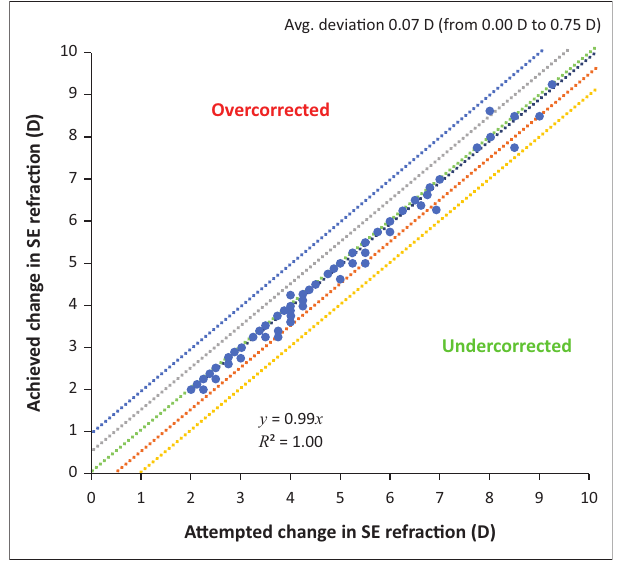
FIGURE 3: Attempted versus achieved SE at 24 months. Scatter graph showing attempted versus achieved spherical equivalent ‘predictability’ of 135 eyes at 2-year post-operative follow up.